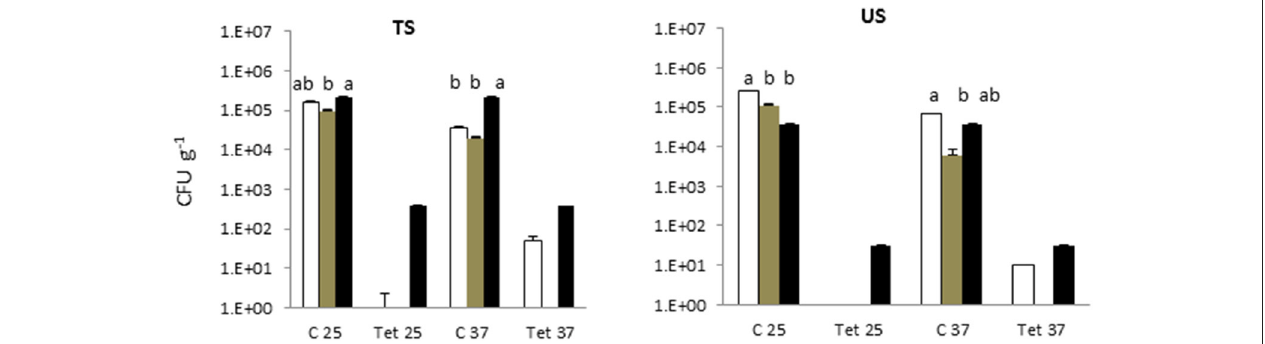
FIGURE 2 | Total bacterial count (TBC) and tetracycline (tet)-resistant bacterial count (TRBC) in the in the soils of the three examined systems in all sampling locations. SYS1 , SYS 2 , SYS 3 . TS (greywater irrigated soil); US (freshwater-irrigated soil). C25, total bacterial count (TC), incubation at 25 ◦ C. Tet25, tetracycline-resistant bacterial count (TRBC), incubation at 25 ◦ C; C37, TC, incubation at 25 ◦ C; Tet37, TRBC, incubation at 37 ◦ C. Error bars represent standard deviation of duplicate plate counts for each of the three examined systems in all sampling location. a, ab, b superscript letters indicate significant differences ( P < 0.05) between the three systems.